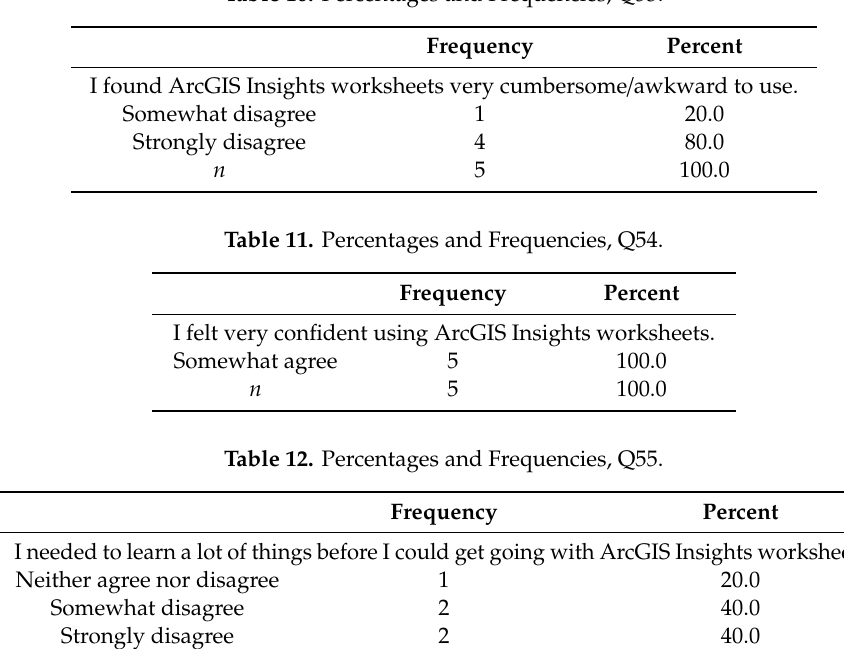
Table 10. Percentages and Frequencies, Q53.